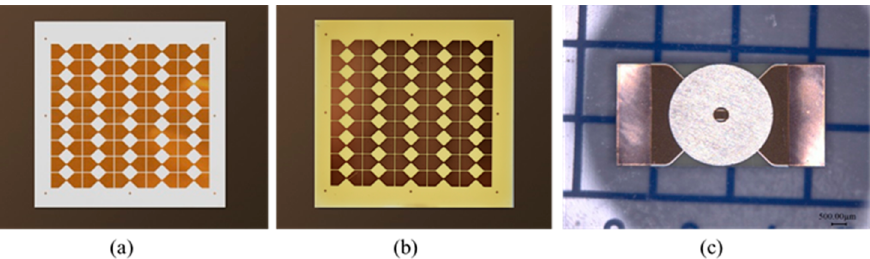
Figure 2. ( a ) Patterned copper film on the ceramic substrate, ( b ) ODPA-ODA polyimide film on the patterned copper film, ( c ) EFI devices with nickel barrel.